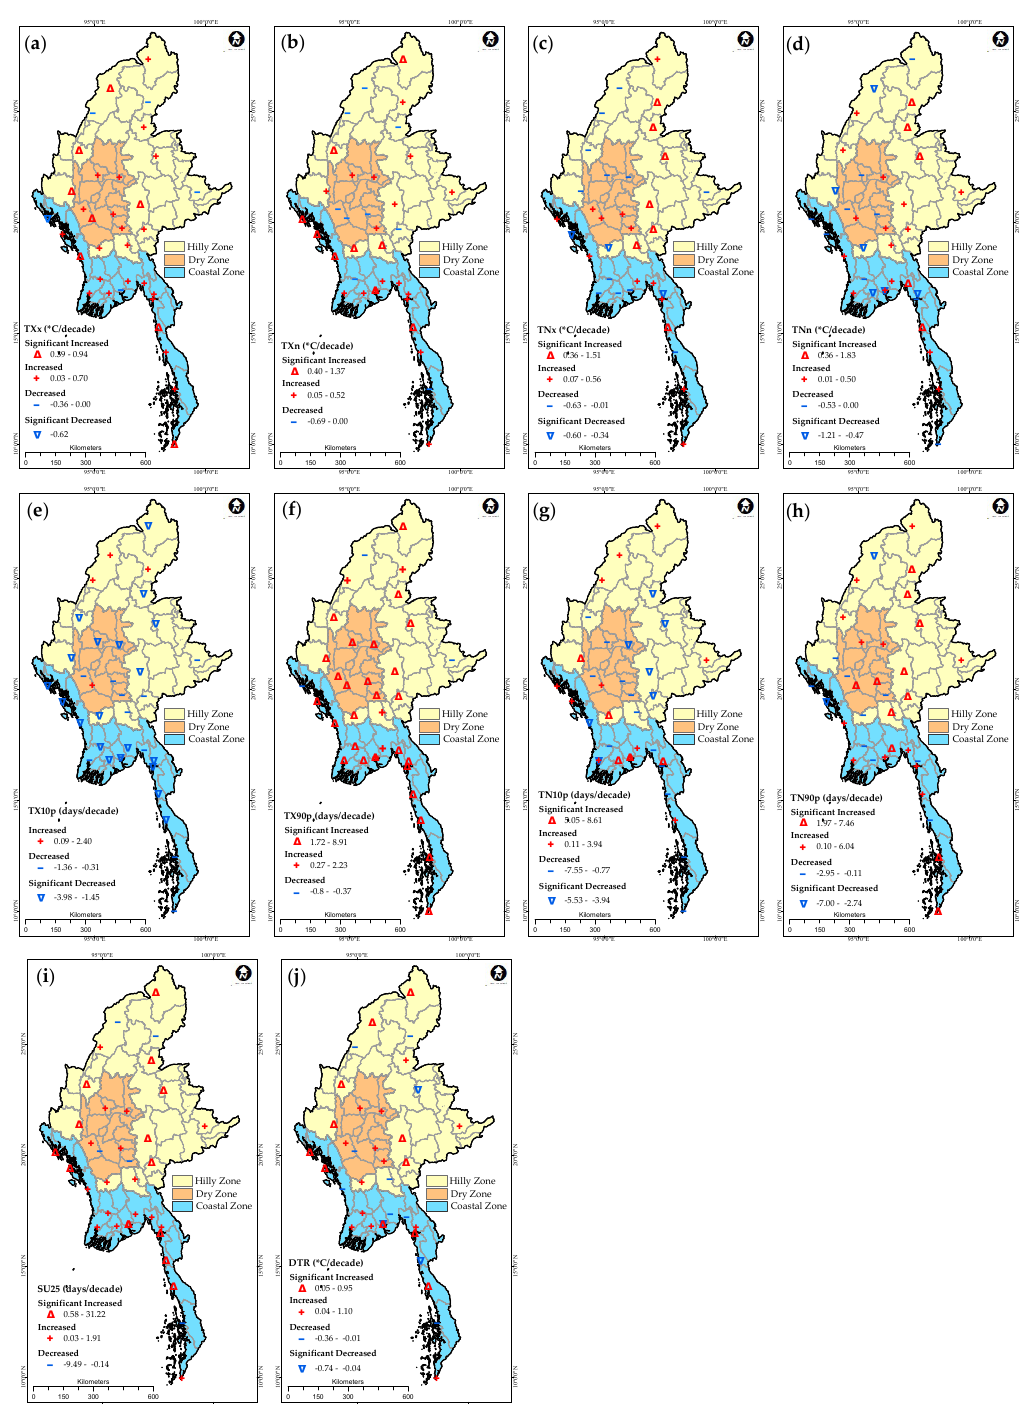
Figure 6. Spatial distribution of trends in extreme temperature indices (per decade) from 1981 to 2015 in Myanmar; ( a ) Max: Tmax (TXx); ( b ) Min: Tmax TXn; ( c ) Max: Tmin (TNx); ( d ) Min: Tmin (TNn); ( e ) Warm days (TX90p); ( f ) Warm nights (TN90p); ( g ) Cool days (TX10p); ( h ) Cool nights (TN10p); ( i ) Summer days (SU25); and ( j ) Diurnal temperature range (DTR). An increase is represented by ( + ) sign, a significant increase with ( Δ ), decrease with ( − ) sign, and significant decreases with ( ) symbol.